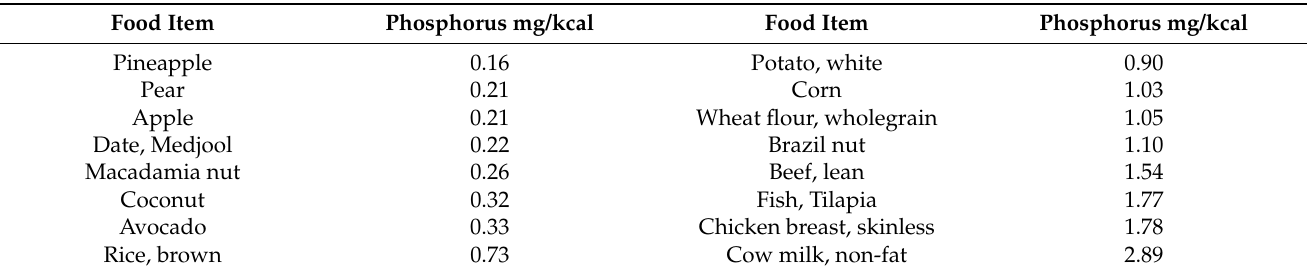
Table 1. Phosphorus caloric density of selected food